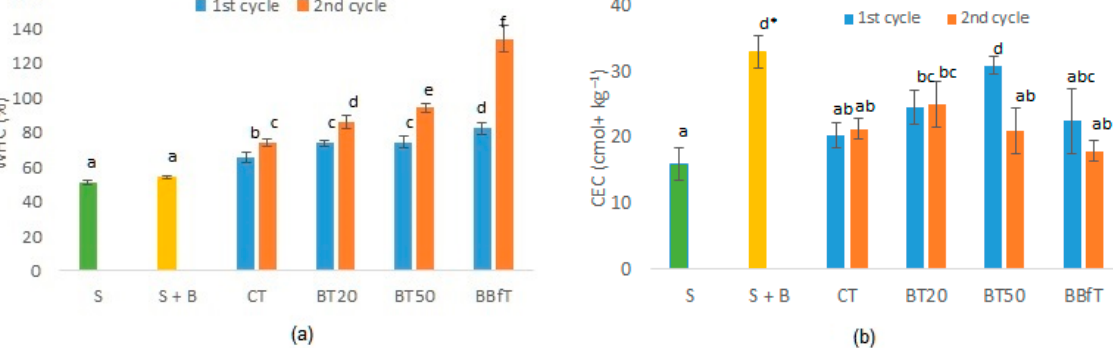
Figure 2. ( a ) Water-holding capacity (WHC) and ( b ) cation exchange capacity (CEC) of studied soil (S), with biochar (S + B), and with different treatments, CT: soil + 100% chemical fertilization, BT20 and BT50: soil + biochar + 20, or 50% of chemical fertilization, respectively, and BBfT: soil + biochar + biofertilization. Different letters and * indicate significant difference ( p < 0.05, Duncan test and one-way ANOVA, respectively).